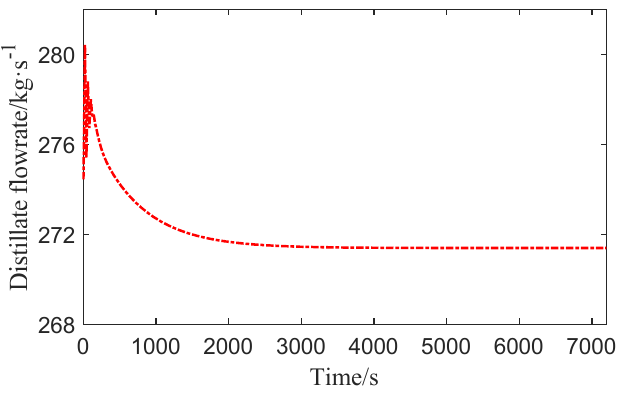
W dynamic response with time. Figure 8. W Figure 8. DN DN dynamic response with time.